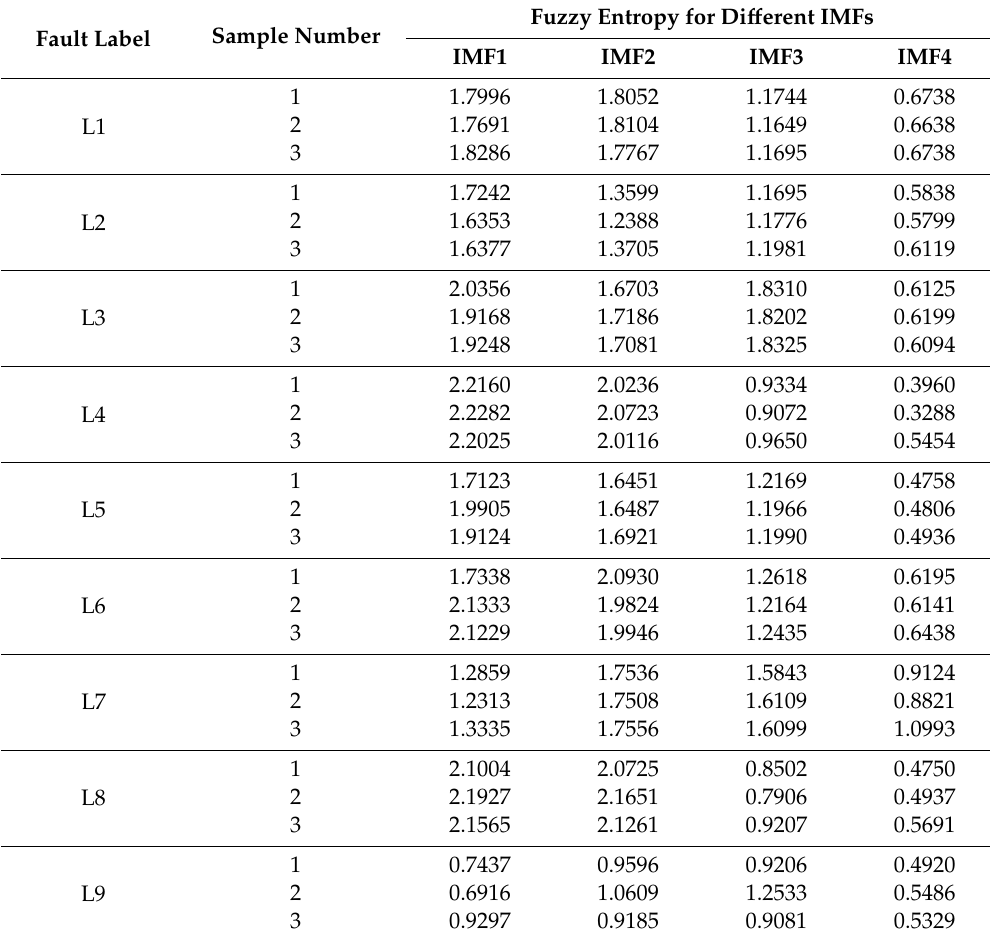
Table 3. Fuzzy entropy values of di ff erent fault